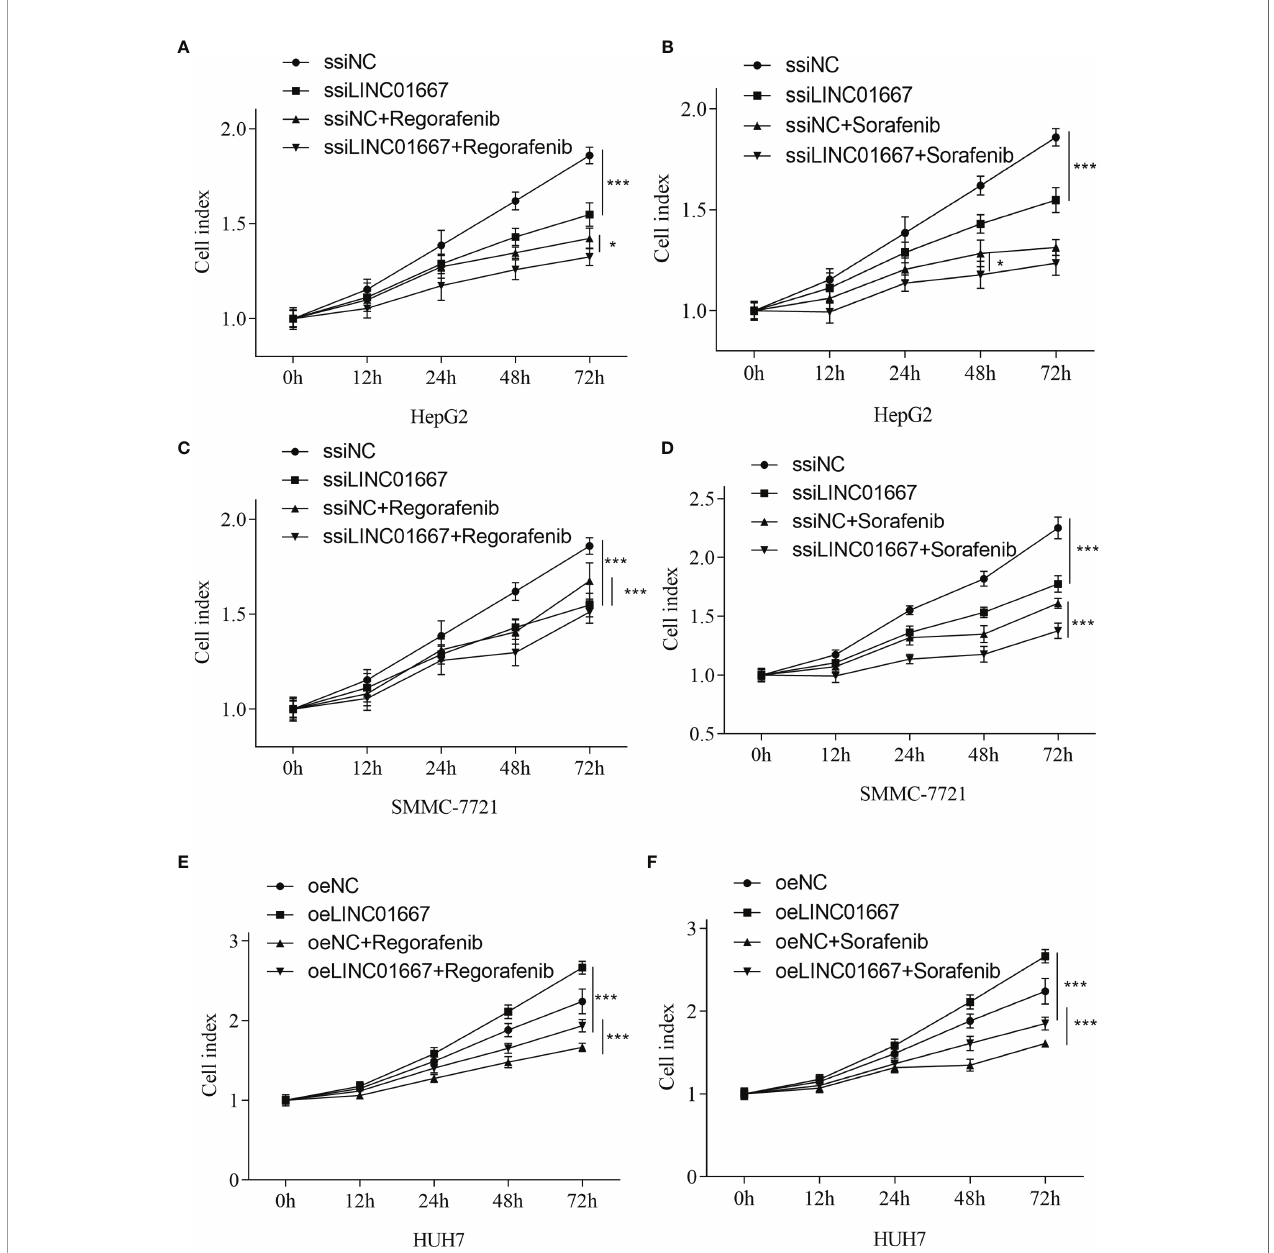
FIGURE 7 | LINC01667 modulates Sorafenib and Regorafenib response in HCC cells. Effect of Regorafenib treatment in cells with (A, C) knockdown of LINC01667 (HepG2 and SMMC-7721) or (E) stable overexpression of LINC01667 (HUH7) compared with the transfected controls. Effect of Sorafenib treatment in cells with (B, D) knockdown of LINC01667 (HepG2 and SMMC-7721) or (F) stable overexpression of LINC01667 (HUH7) compared with the transfected controls. All experiments were performed in 5 copies. *P < 0.05, ***P < 0.001. oeNC represents the empty vector group, and oeLINC01667 represents the overexpression LINC01667 group, ssiNC represents the random sequence group, and ssiLINC01667 represents the knockdown LINC01667 group.